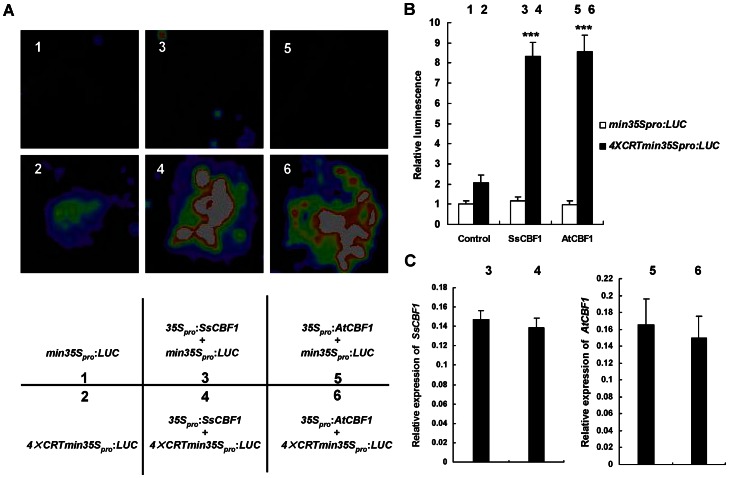
Transactivation of promoters with CRT elements only.(A) Transient expression assays showing that SsCBF1 and AtCBF1 specifically bind to the CRT elements and activate the expression of LUC reporter gene. The bottom panel indicates the combination of reporter and effector plasmids infiltrated. The LUC reporter gene is driven by a promoter with or without four tandem CRT elements fused upstream of a minimal (−46) 35S promoter sequence (min35Spro). The effector CBF1 genes are under the control of the CaMV35S promoter. Representative images of N.benthamiana leaves 72 h after infiltration are shown. (B) Quantitative analysis of luminescence intensity in (A). Five independent determinations were assessed. Error bars represent SD. Asterisks denote Student's t-test significance levels compared with the control: ***P<0.001. (C) qRT-PCR analysis of SsCBF1 and AtCBF1 expression in the infiltrated leaf areas shown in (A). Total RNAs were extracted from leaves of N. benthamiana coinfiltrated with the constructs. Five independent determinations were assessed. Error bars represent SD.